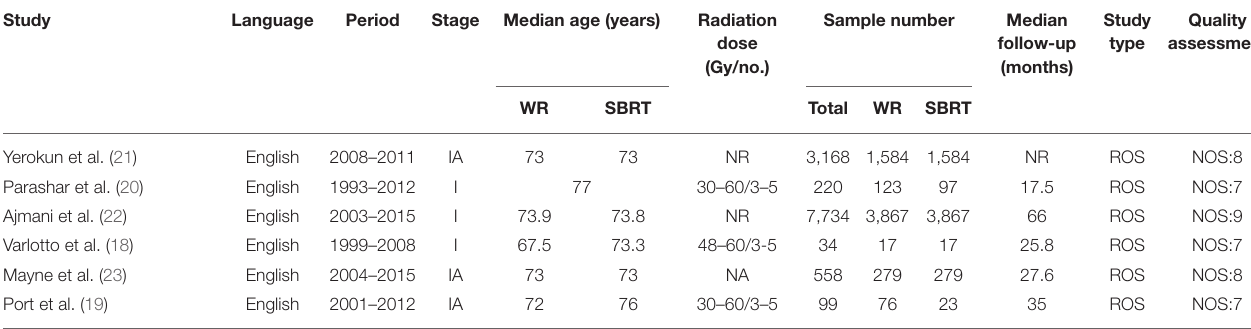
TABLE 1 | Characteristics of selected studies. Study Language Period Stage Median age (years) Radiation